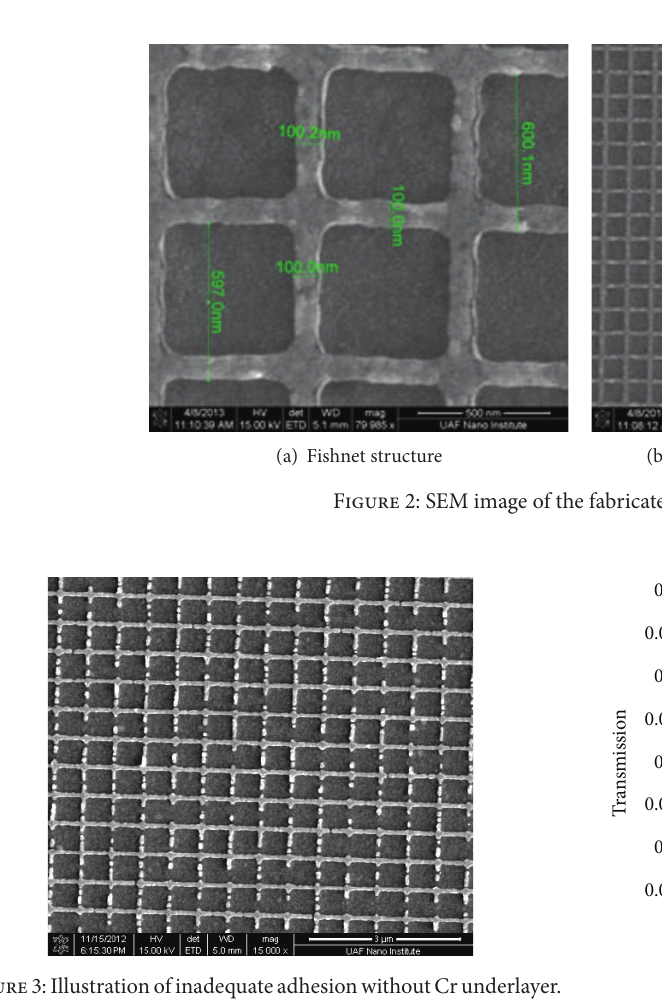
Figure3:IllustrationofinadequateadhesionwithoutCrunderlayer.